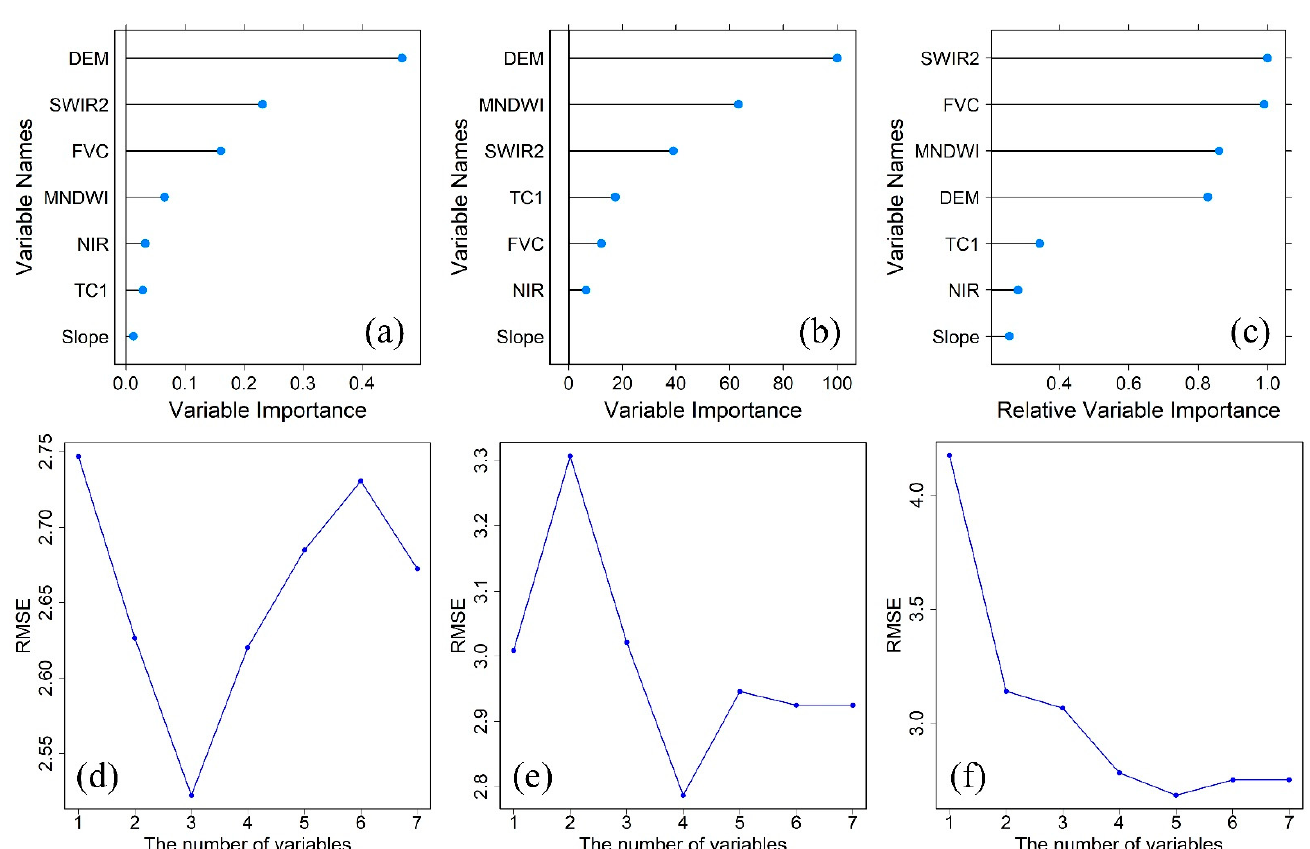
Figure 3. Graphs ( a – c ) display the scores and ranks of the variable importance provided by the XGBoost, multivariate adaptive regression splines (MARS), and Bayesian ridge regression (BRR) models, respectively. Graphs ( d – f ) display the predictive root mean square error (RMSE) values (K) of the XGBoost, MARS, and BRR models, respectively, varying with the number of variables.